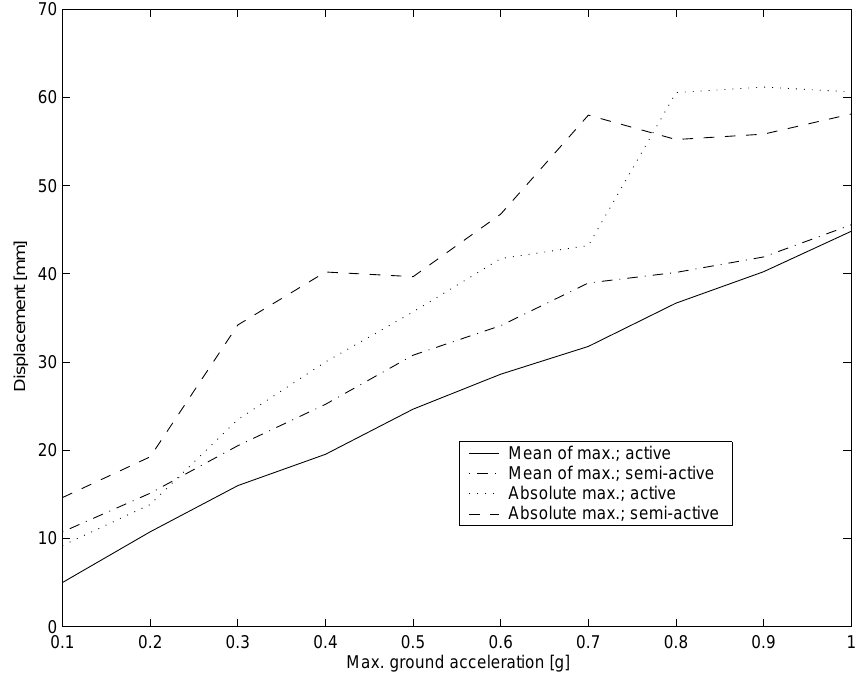
Fig. 9. The absolute maximum and average of the maximum actuator stroke values calculated for the ensemble of time histories for different levels of ground motion